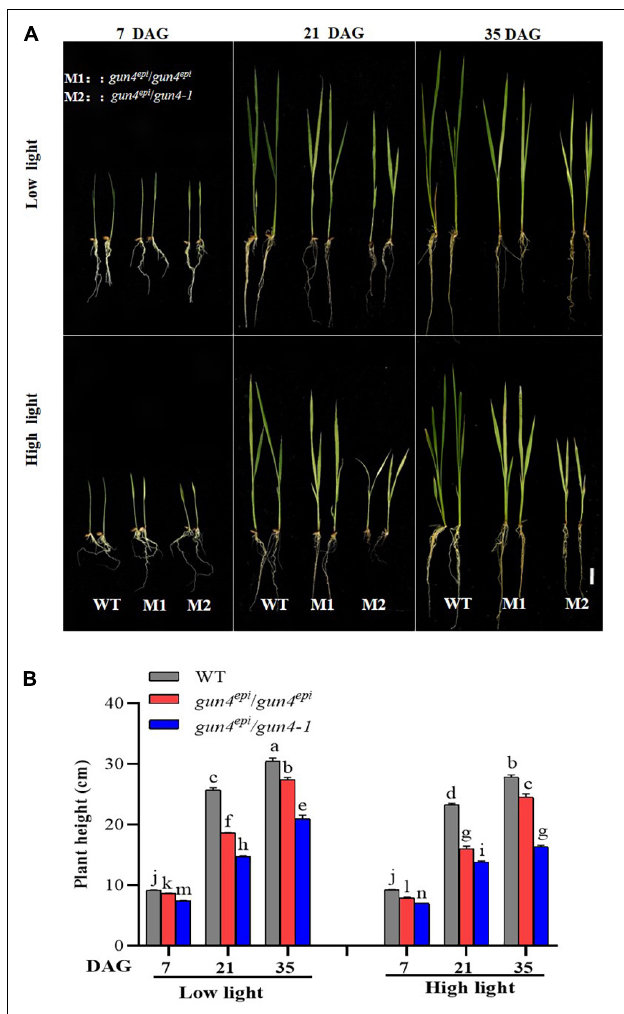
FIGURE 2 | Effects of high light on growth of the OsGUN4 mutants. (A) The phenotype and (B) plant height of wild-type (WT; c.v. LTB) and F 2 seedlings derived from gun4 epi / gun4-1 F 1 plants at 7, 21, and 35 days after germination (DAG). Values are means ± SD ( n = 6) and analyzed for significant differences by two-way ANOVA followed by the Tukey’s multiple comparison test, P < 0.05. Scale bar = 3 cm. For the background information of the F 1 plants, see Supplementary Figure 1 .